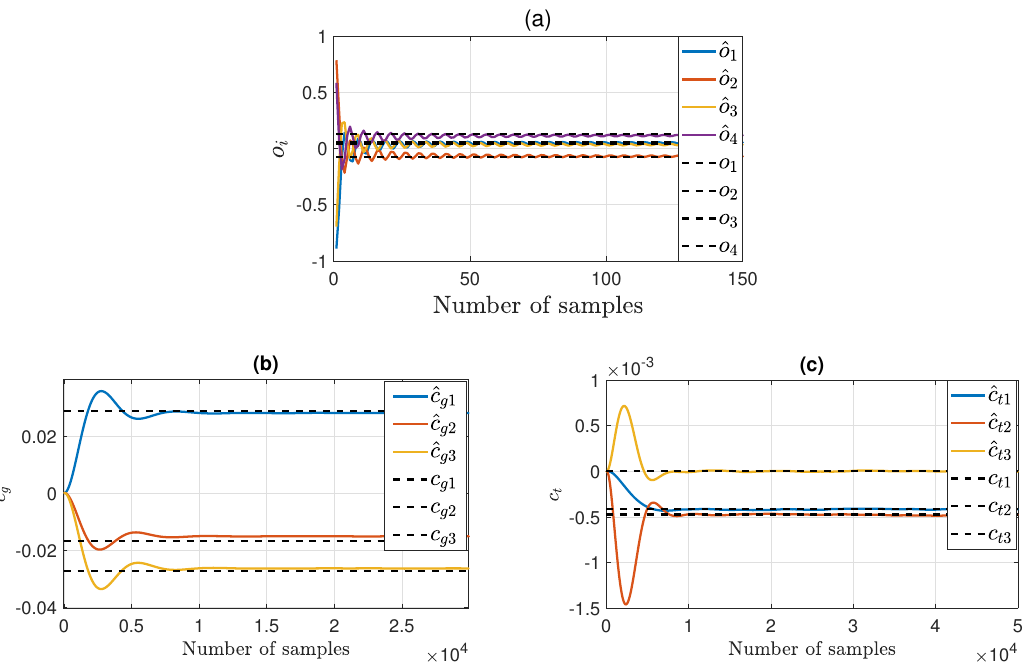
Figure 7. Convergence behavior of channel mismatches with the proposed technique: ( a ) offset, ( b ) gain, and ( c )